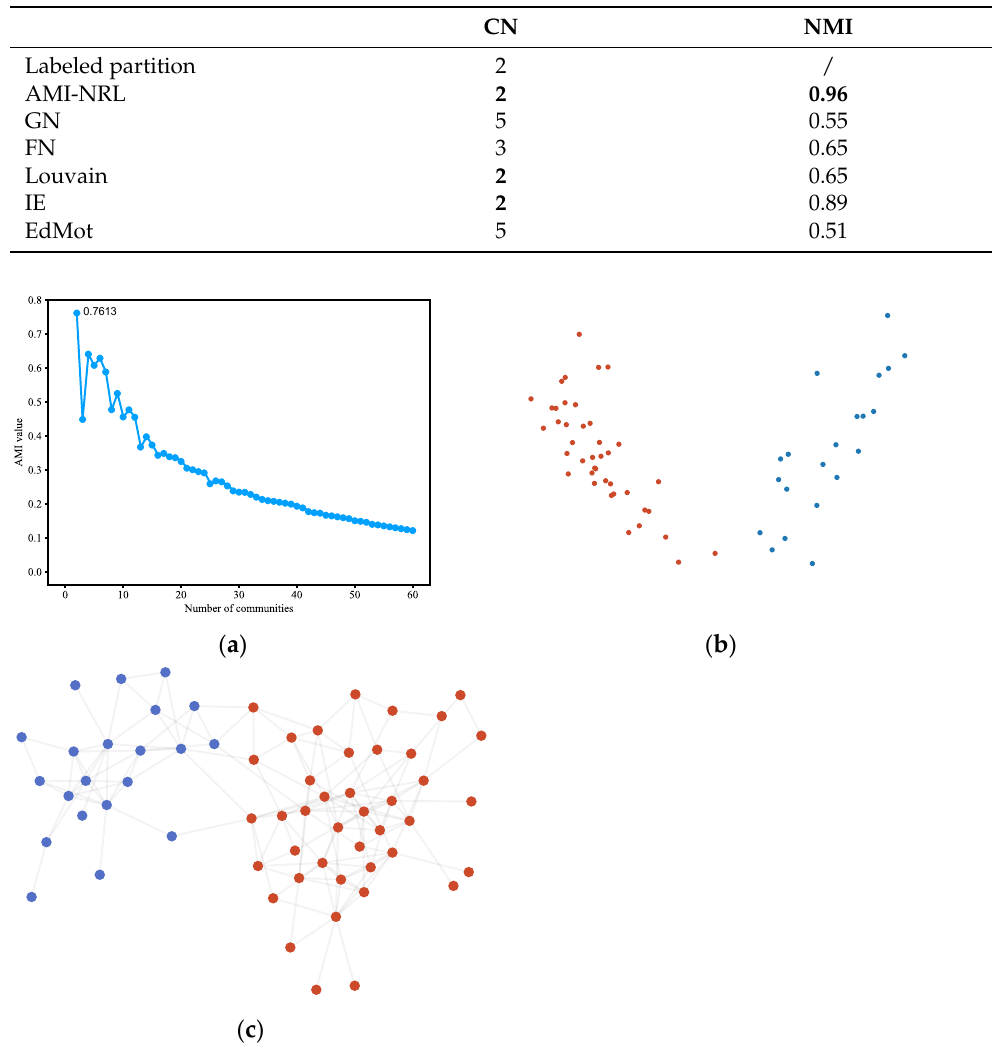
Figure 3. ( a ) AMI variation graph of adjacent partitions of Dolphins. ( b ) Vectors representing each node of Dolphins. ( c ) Result of community detection on Dolphins.